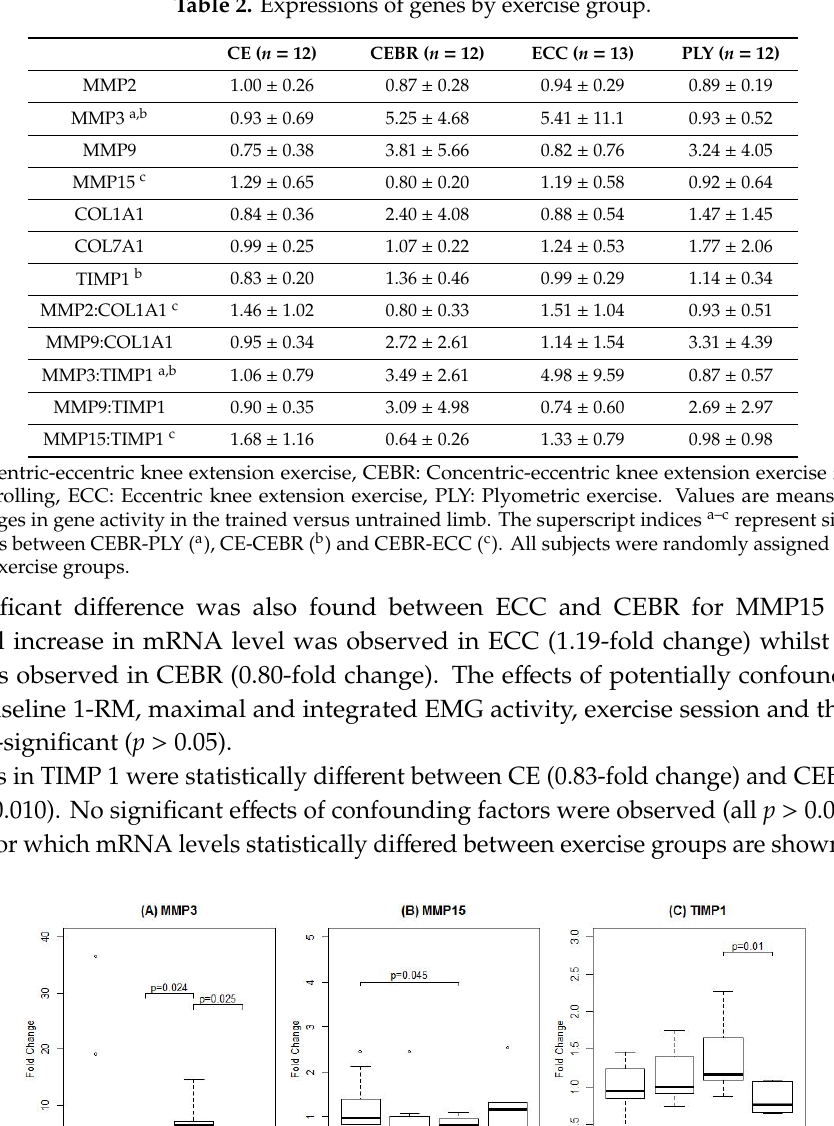
Table 2. Expressions of genes by exercise group.